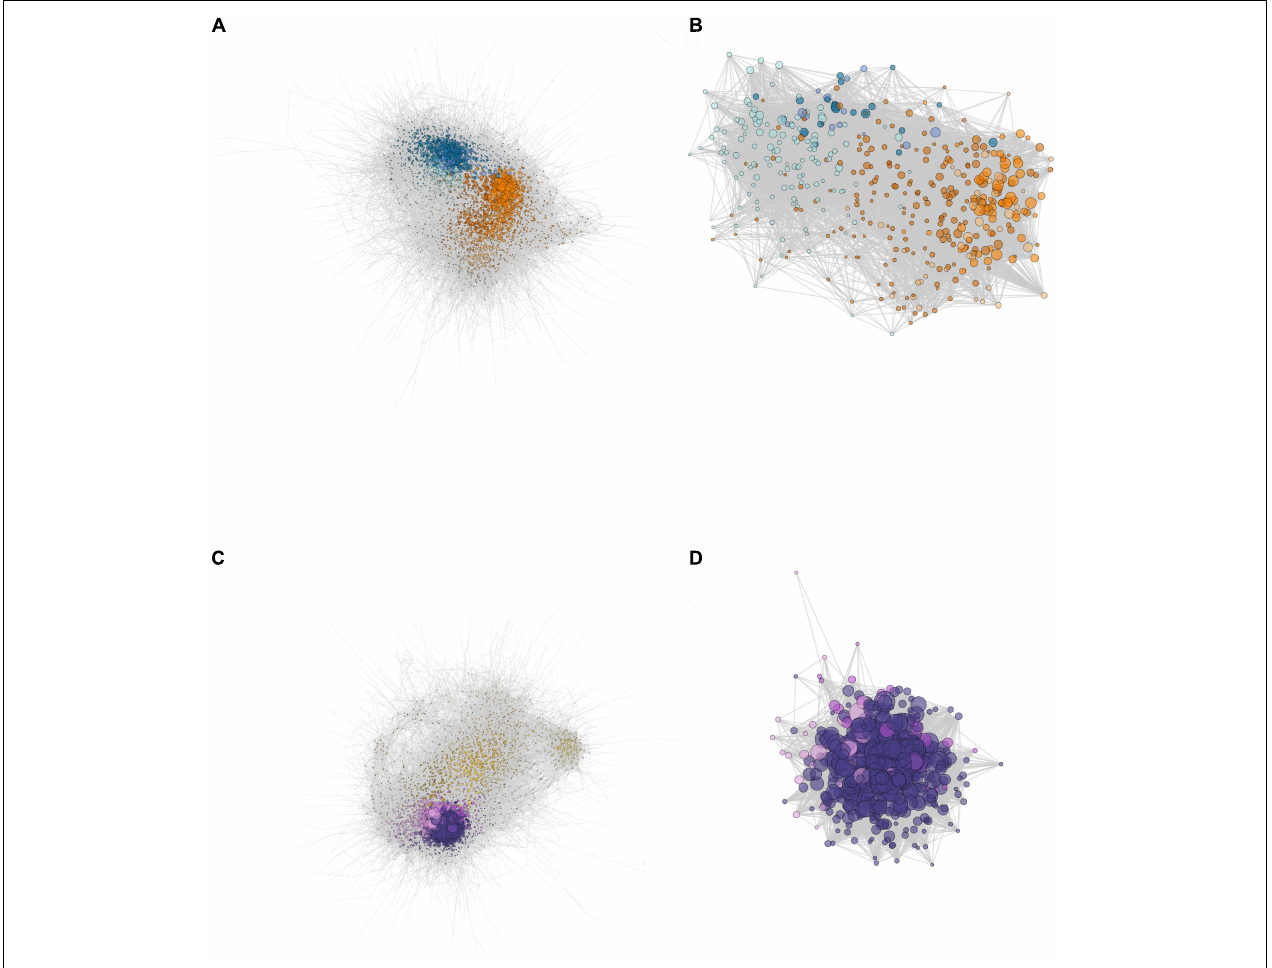
FIGURE 5 | Network constructions of (A) E. pusilla and (C) E. crista-galli based on ARACNe network analysis, and the ring finger seed longevity ( RSL1 ) subnetworks for (B) E. pusilla and (D) E. crista-galli calculated via the diffusion algorithm in Cytoscape. Colors correspond to Figure 3 cluster colors – cooler colors (blues in A and B and purples in C and D ) are clusters that have an increase in expression at night and warmer colors (oranges in A and B and yellows in C and D ) are clusters that have increases in expression during the day. Dots represent genes, scaled by the number of edges (maximum number of directed edges =